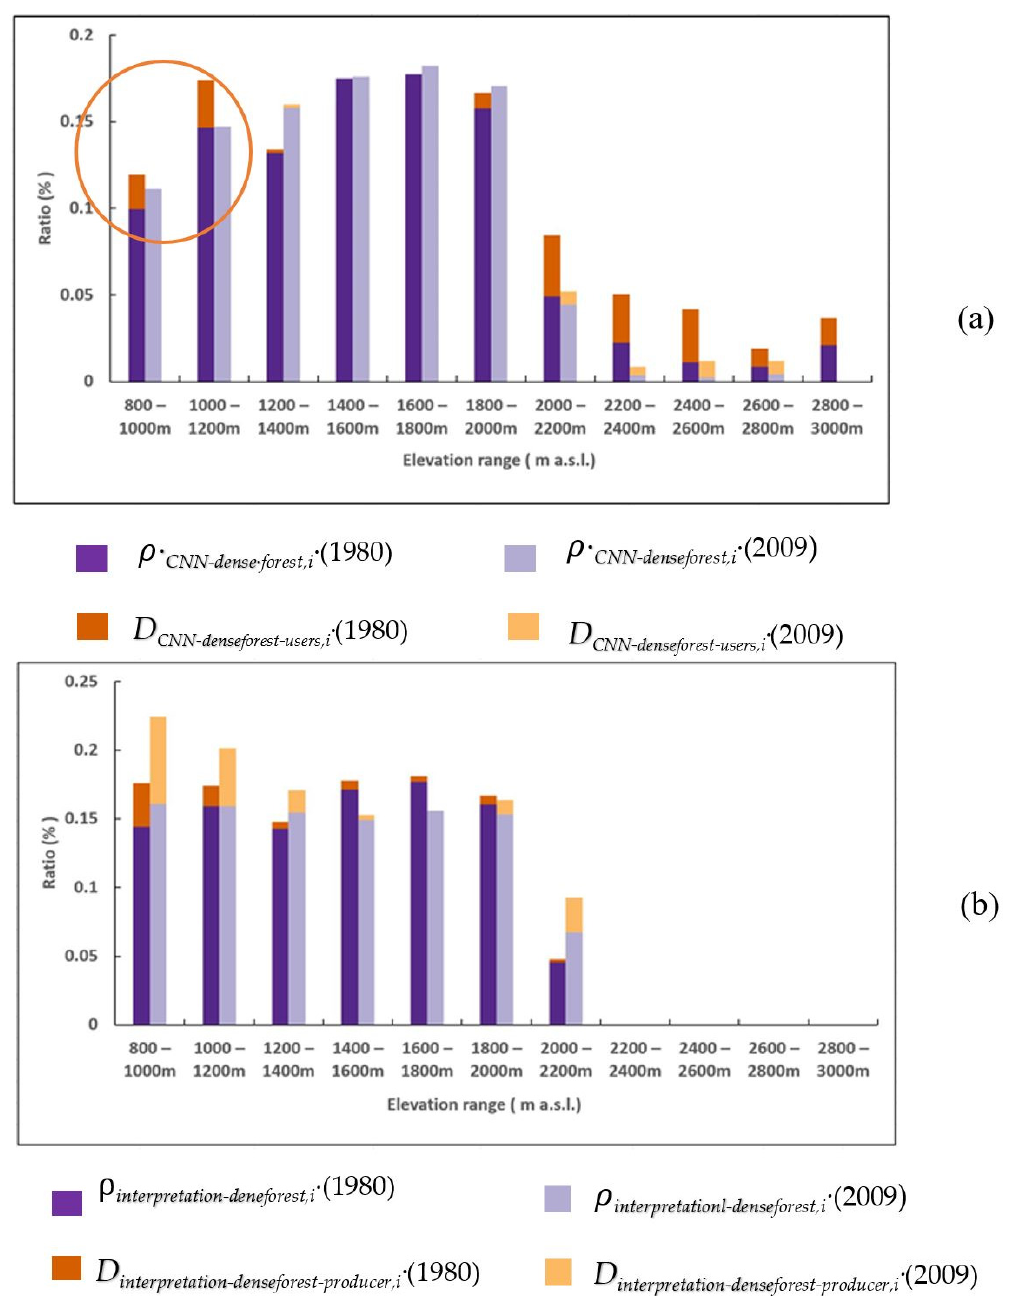
Figure 13. ( a ) User’s disagreement for the class “dense forest” ( b ) Producer’s disagreement for the class “dense forest”. Disagreement values ( ρ CNN , D CNN , ρ interpretation , D interpretation ) are from both dates (1980, 2009) for each elevation category in study area 2. The circle shows that some image patches were not classified as “dense forest” compared with visual image